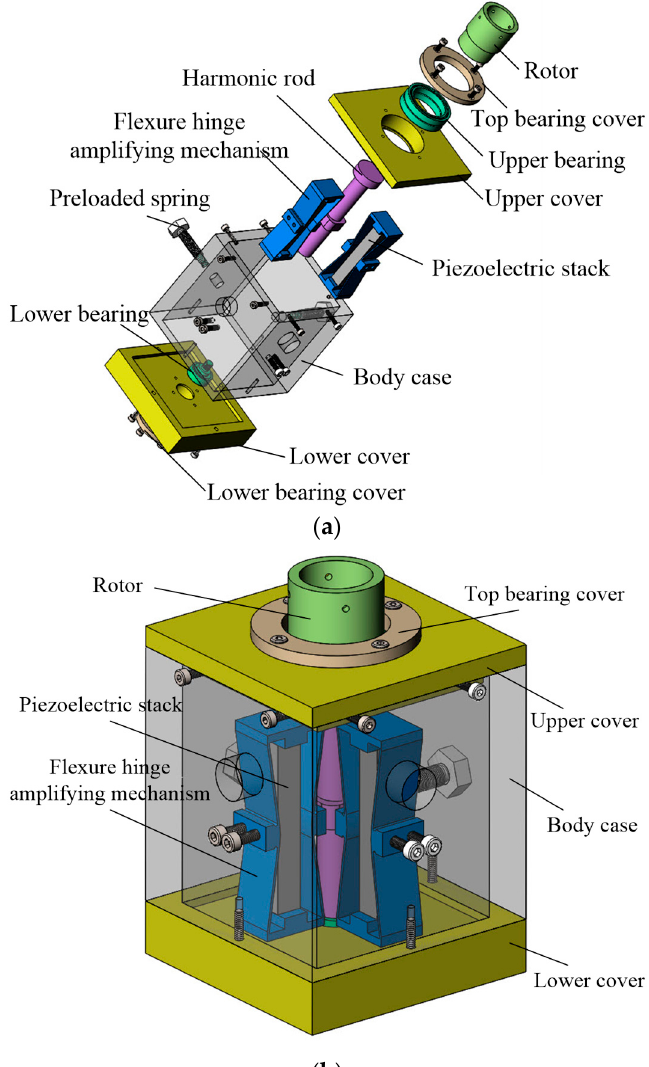
Figure 4. Structure of the low-frequency harmonic rotating piezoelectric actuator. ( a ) The exploded drawing; ( b ) The assembly drawing.